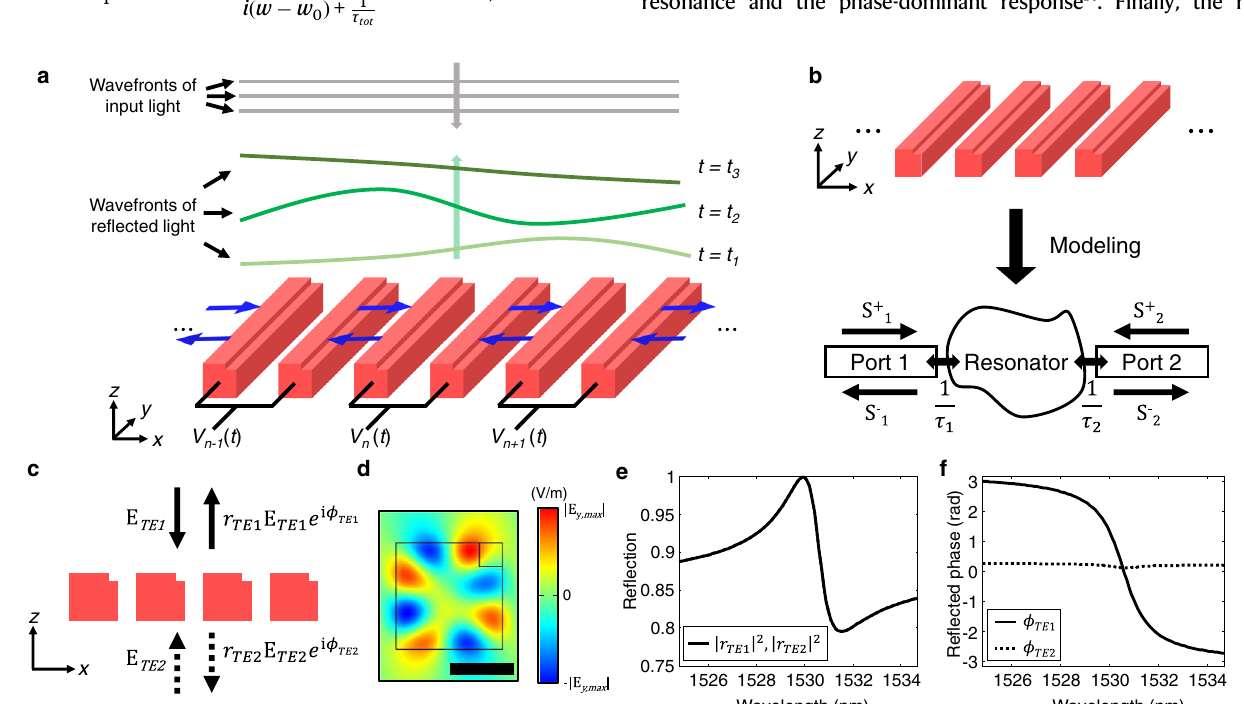
Fig.1|Conceptualschematicofnano-electromechanicallytunableasymmetric metasurfaces and numerical investigations of their resonant re fl ection beha- vior. a Conceptual illustration of the nano-electromechanically tunable meta- surfaces composed of asymmetric suspended nano-beams. Each pair of nano- beams is connected to individually addressable electrodes. The electrical biases induce electrostatic forces between the neighboring bars, leading to lateral movementsalongthe x axis(seebluearrows).Theasymmetricmetasurfacere fl ects normallyanincidentplanewaveanddynamicallymanipulatesthewavefrontofthe re fl ected light as a function of the applied biases. t 1 , t 2 , and t 3 represent different electrical biasing conditions. b Schematic of a periodic metasurface (top) and illustration of the corresponding analytical model based on an optical resonator coupled to two ports (bottom). The model describes the asymmetric metasurface undernormalincidentlight. S + 1 ( S + 2 )and S (cid:2) 1 ( S (cid:2) 2 )areincoming and outgoingwaves